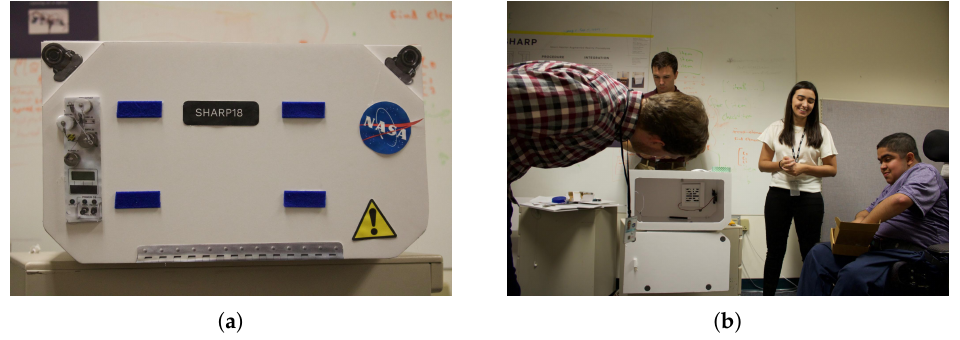
Figure 2. ( a ) ISS Locker Prototype ( b ) Initial locker